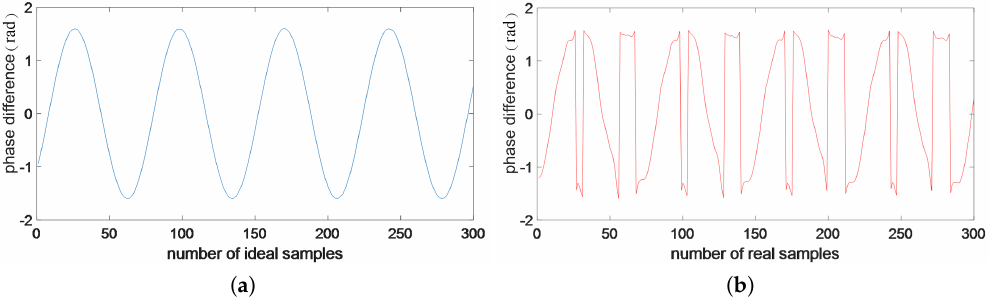
Figure 4. Phase difference of ideal simulation signal and actual signal between the first and second elements. ( a ) Phase difference of ideal simulation signal. ( b ) Phase difference of actual